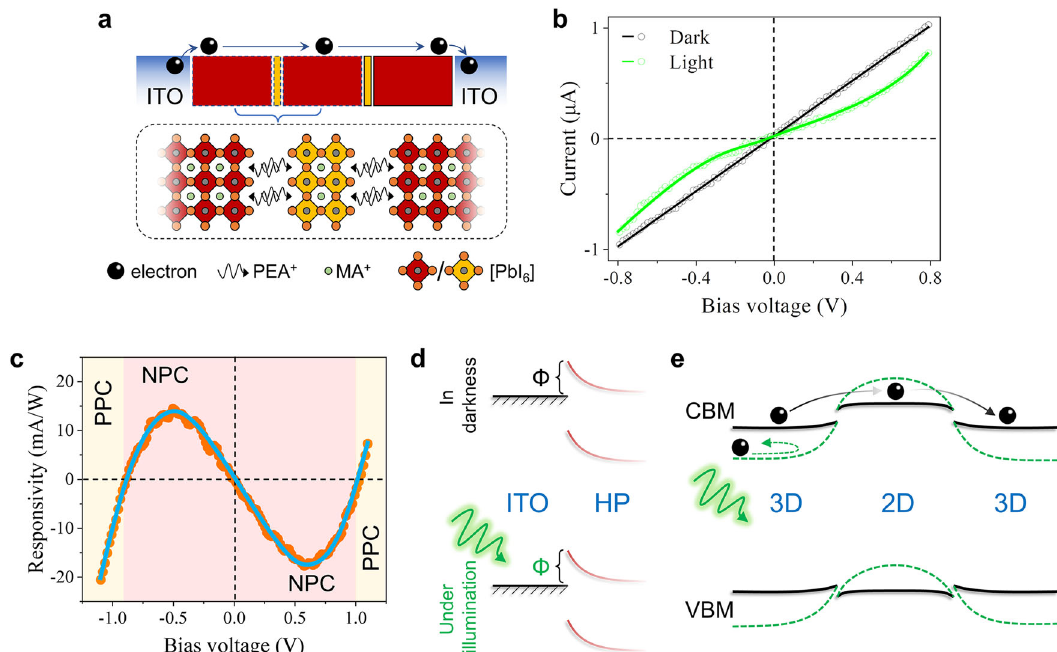
Fig. 2 | Carrier transport of the GIHP fi lm in darkness and under illumination. a Schematic diagram of the two-terminal ITO/GIHP fi lm/ITO device con fi guration for optoelectronic measurements. b The corresponding I - V characteristics in darkness and under illumination. c The bias-dependent responsivity of the GIHP fi lm. d SchematicdiagramsoftheunvariedSchottkybarrierheightoftheITO/GIHP